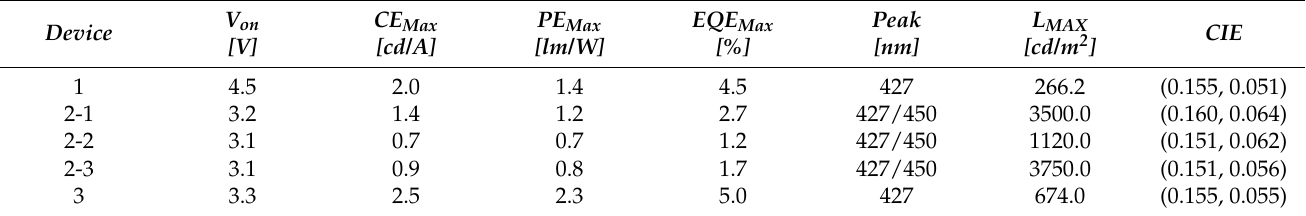
Table 1. The EL performance summary of the prepared devices in this